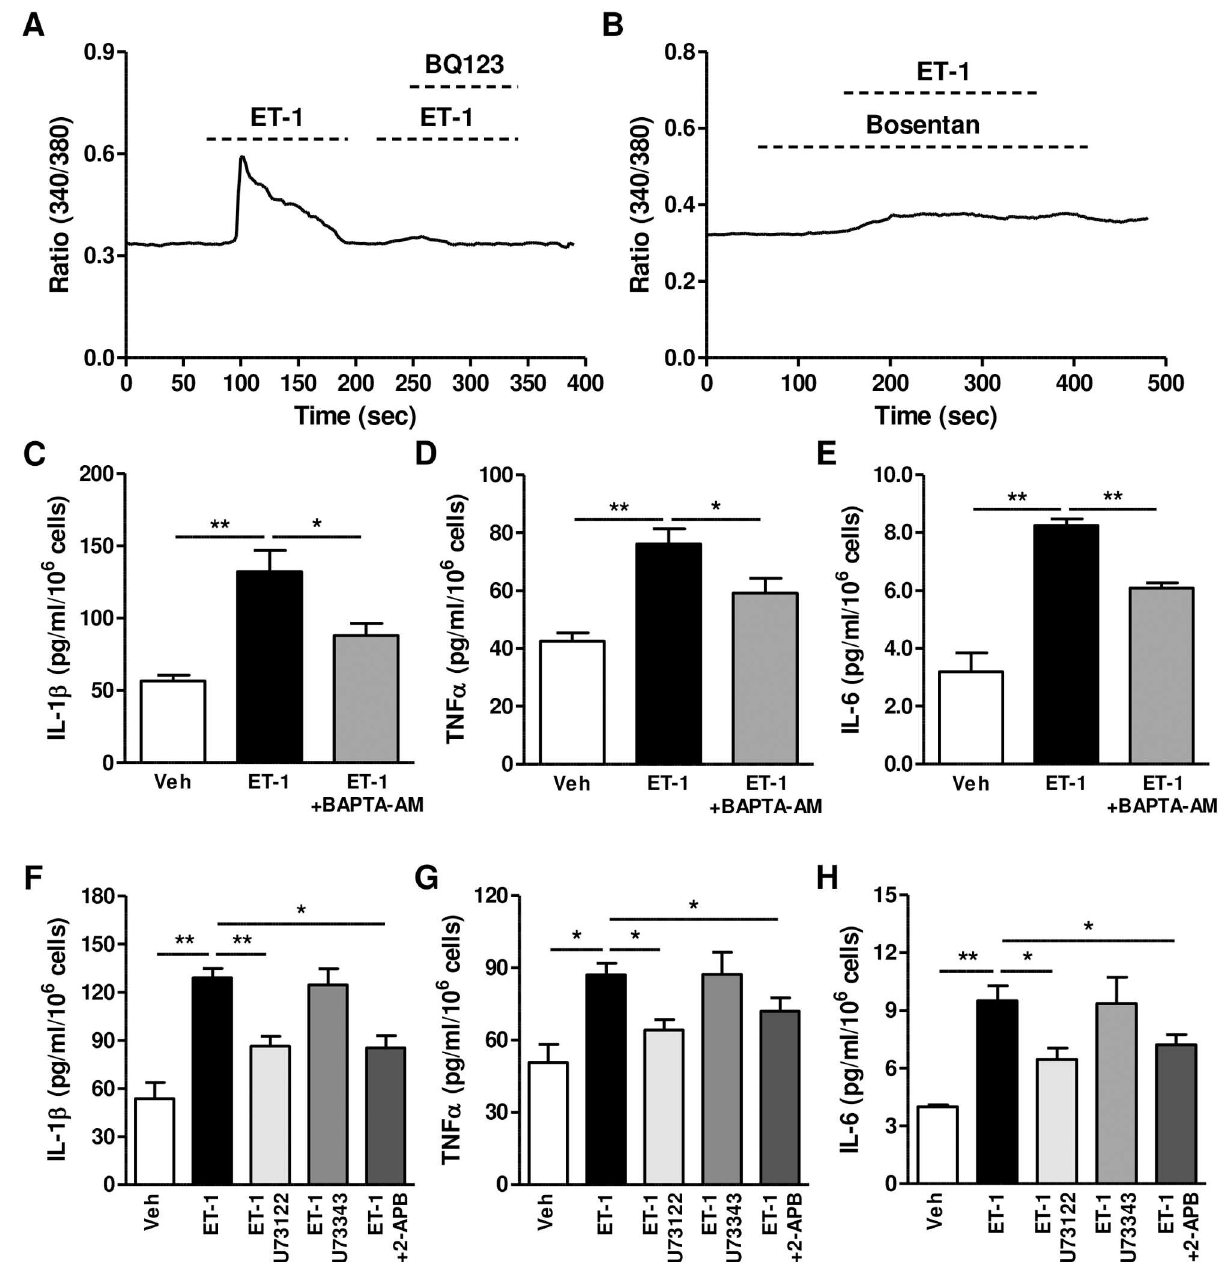
Fig 3. Involvement of the Ca 2+ /PLC/IP 3 pathway in endothelin-mediated inflammatory cytokine production. (A and B) ET-1-induced increase in intracellular Ca 2+ concentration [Ca 2+ ] i . The fura-2/AM- stained cells were treated with ET-1 and BQ123 (100 nM) (A) or bosentan(100 nM) (B). Changeof [Ca 2+ ] i was measuredthrough fluorescence intensity at excitationwavelengths of 340 and 380 nm. (C to E) Effect of BAPTA-AM on ET-1-mediatedproduction of inflammatory cytokines. After pre-treatment with BAPTA-AM (5 μ M) for 20 min, HGECs were treated with ET-1 (100 nM) for 24h and productionof IL-1 β (F), TNF α (G), and IL-6 (H) was measuredby ELISA in culture supernatantsfrom five samples (sample#1–5). * P < 0.05; ** P < 0.01.(F to H) Involvement of the PLC/IP 3 pathwayin the ET-1-induced productionof inflammatory cytokines. After pre-treatment with U73122(10 μ M), U73342(10 μ M), or 2-APB (75 μ M) for 30 min, HGECs were treated with ET-1 (100 nM) for 24h and productionof IL-1 β (C), TNF α (D), and IL-6 (E) was measuredby ELISA in culture supernatantsfrom five samples (sample#1–5). * P < 0.05; ** P <